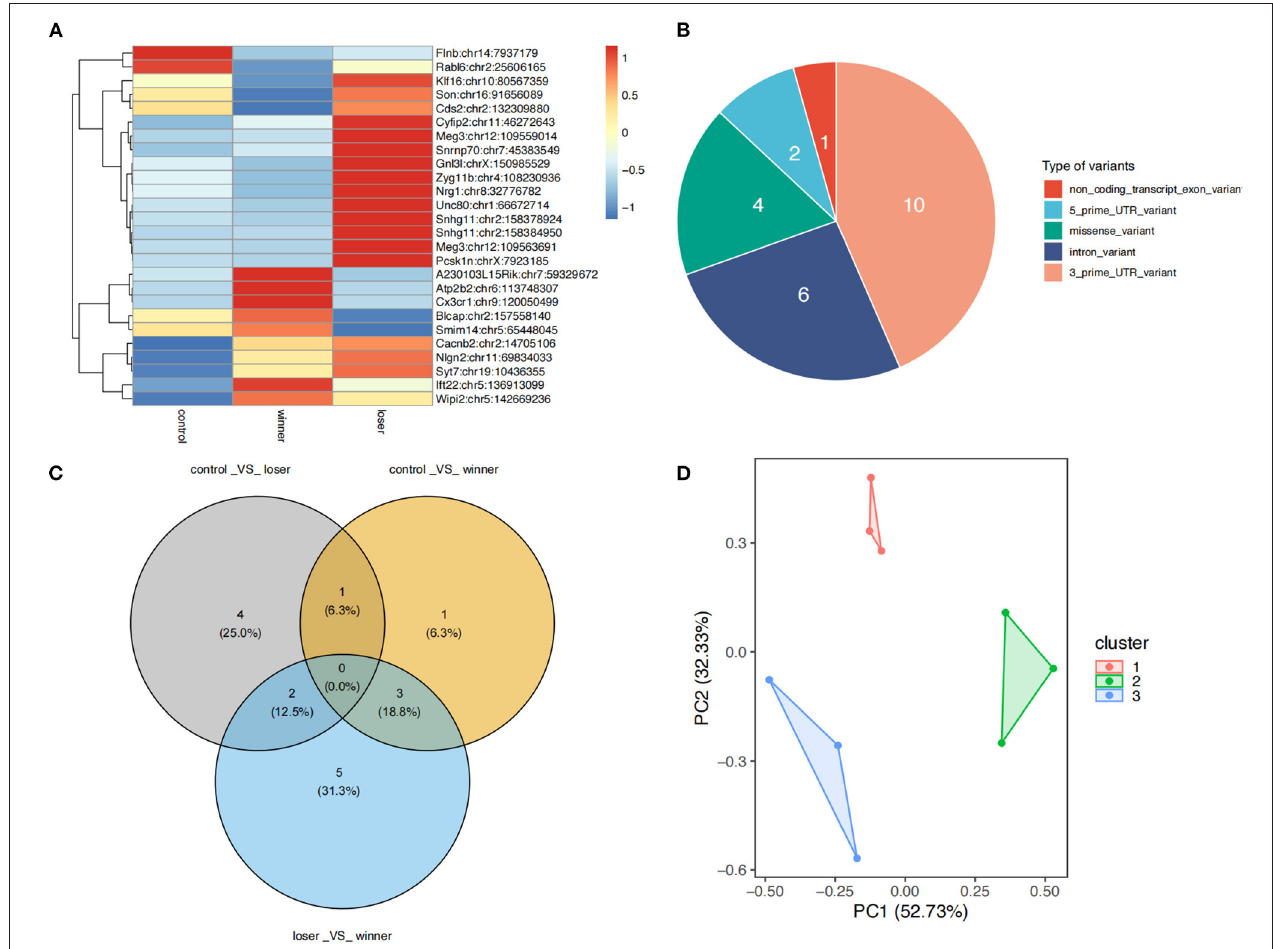
FIGURE 3 | Differential A-to-I RNA editing sites among controls, winners, and losers. (A) A total of 23 DRE sites are found. (B) Functional categories of various types of DRE sites. (C) Principal component analysis of the 23 DRE sites among the three groups. (D) Venn plots showing the comparison of DRE sites showing significance in post-hoc tests. The post-hoc tests are conducted for pairwise comparisons among controls, winners, and